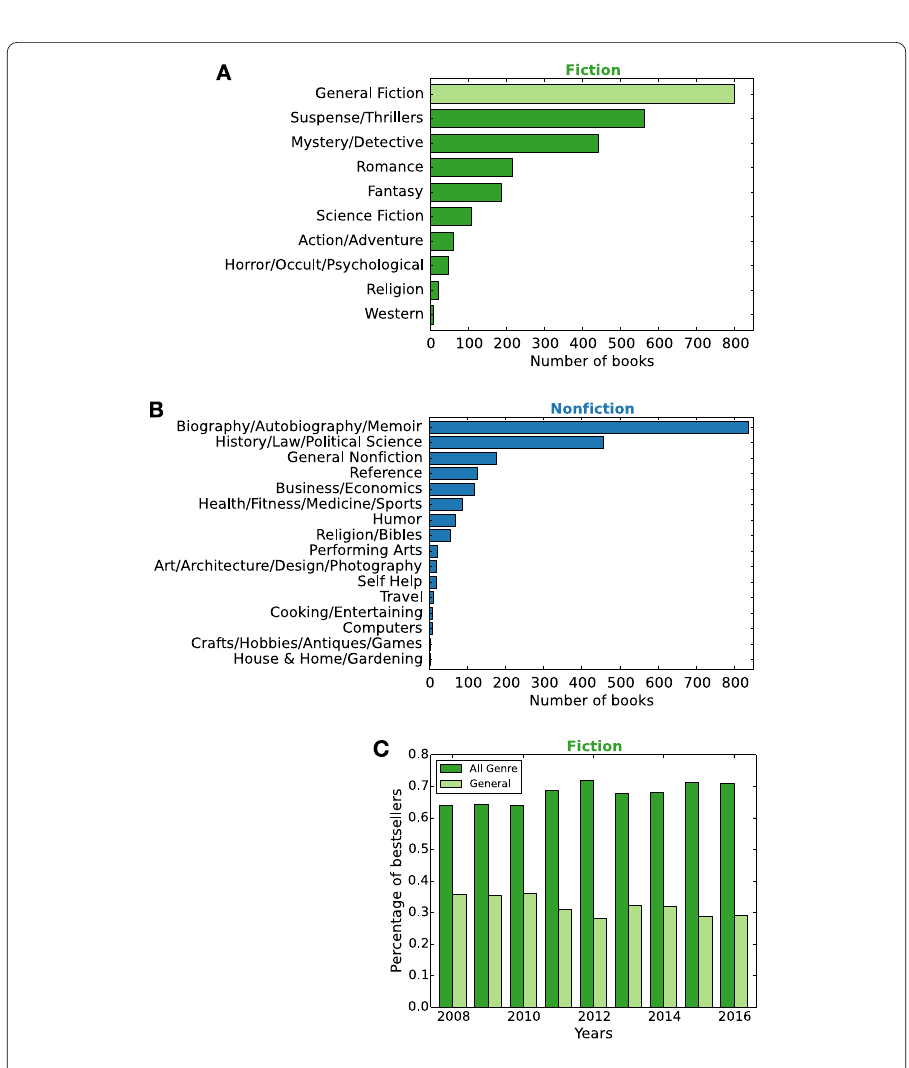
Figure 1 Genrepopularities . The breakdown of bestsellers into genre categories of ( A ) fiction and ( B ) nonfiction. Most bestsellers fall into Suspense and Mystery genres combined in fiction or Biography/Memoir and History genres in nonfiction. ( C ) The percentage of genre fiction (all fiction that can be classified as a specific genre, shown in dark green) and general fiction (all else, shown in light green) on